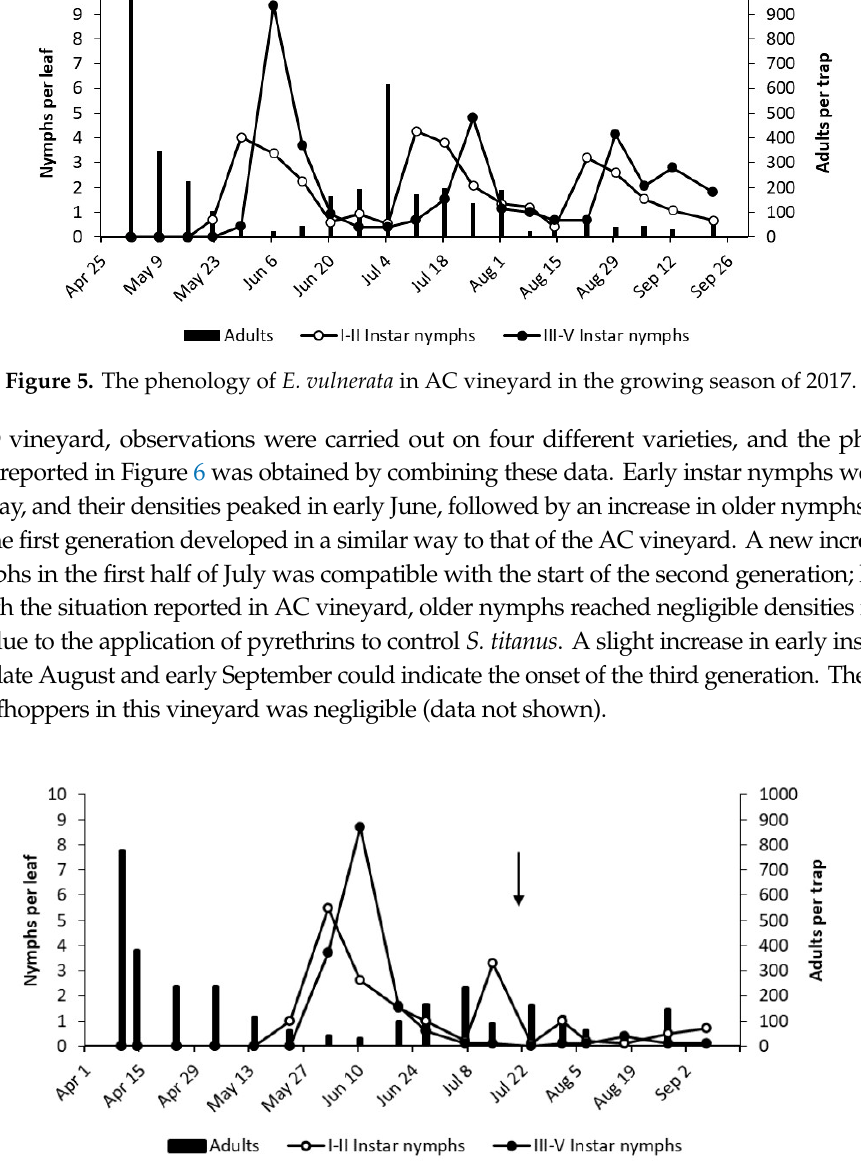
Figure 7. The phenology of E. vulnerata in MO vineyard in the growing season of 2018. Figure 8. The phenology of E. vulnerata in LO2 vineyard in the growing season of 2018.